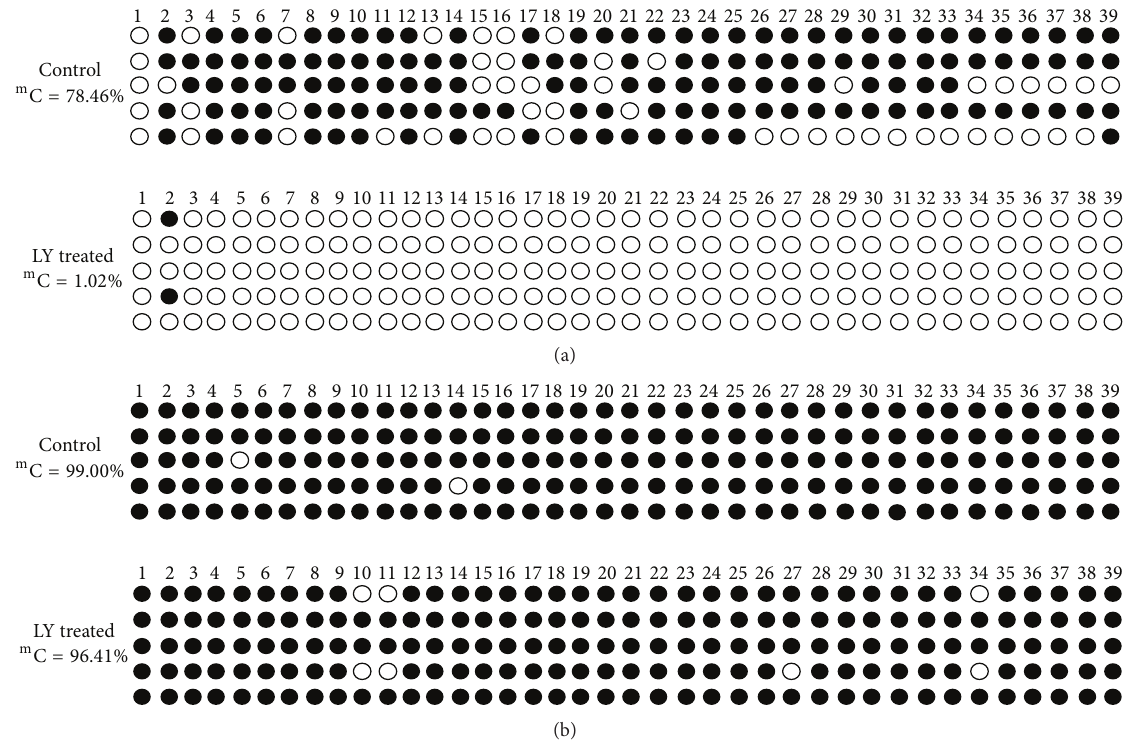
Figure 1: Effects of lycopene treatment on DNA methylation of GSTP1 gene in PCa cells. (a) methylation levels of the GSTP1 promoter in lycopene treated PC-3 and control cells. (b) methylated cytosines of GSTP1 promoter in lycopene treated LNCaP cells and control cells. m C, methylated cytosine. LY,